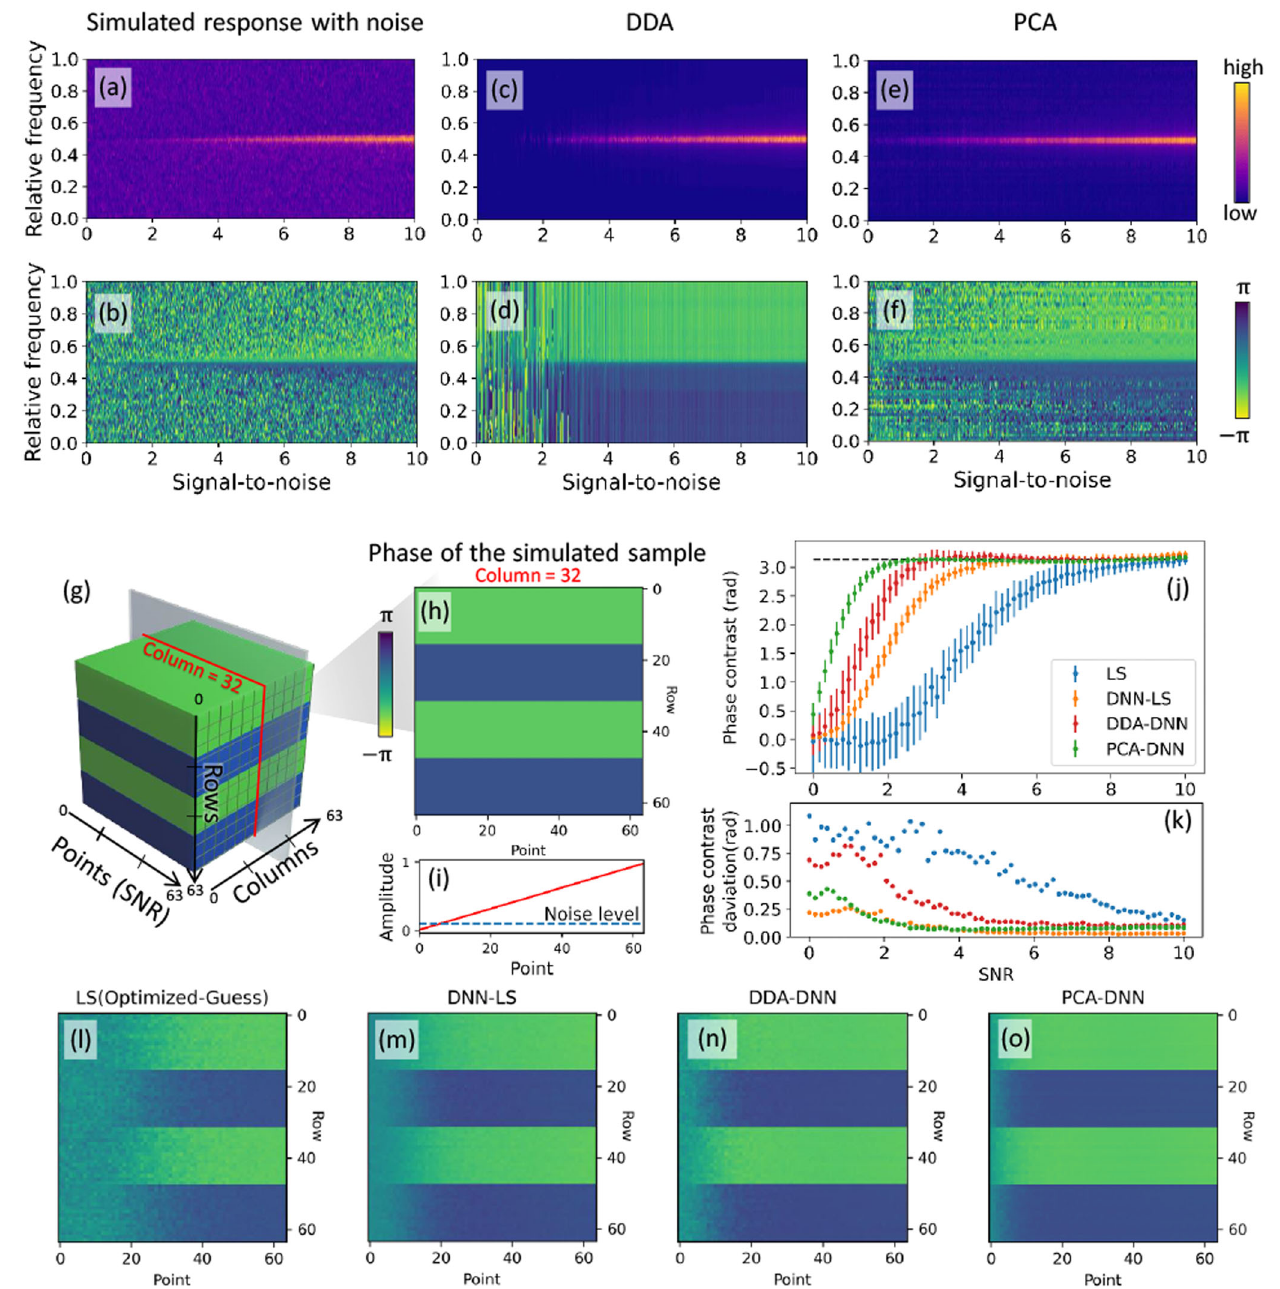
Fig. 2 Noise reduction and phase contrast evaluation of the simulated piezoelectric domains. a – f Noise reduction of the simulated SHO dataset using DDA and PCA: ( a , c , e ) amplitude and ( b , d , f ) phase as a function of SNR. a , b Simulated SHO data with a constant noise level, quality factor, phase, and reducing amplitude in the SNR axis, and ( c – f ) denoised data using DDA and PCA, respectively. g Visualization of the simulated signal for phase contrast evaluation, in which the phase parameter of the response is speci fi ed as two values of – π /2 and π /2, equivalent to the positive and negative polarization orientation, respectively. h The points-rows plan shows the phase of the simulated signal extracted from ( g ) at column number 32. i Amplitude variant with a constant noise level along the point axis. We note that the point and SNR are equivalent axes. j Phase contrast and ( k ) corresponding deviation were extracted from the SHO fi tting and prediction results of ( l ) LS with the optimized initial guess method, ( m ) DNN-LS, ( n ) DDA-DNN, and ( o ) PCA-DNN. The phase contrast is calculated by the difference between the average values of two phases, that is, the phase represented by blue and green in ( h